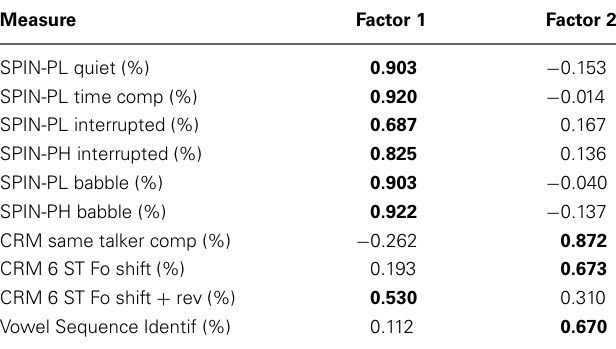
Weights > 0.4 are shown in bold typeface. Table 5 | Component weights from the pattern matrix for each speech-understanding measure on each of the two oblique principal components identified via factor analysis.